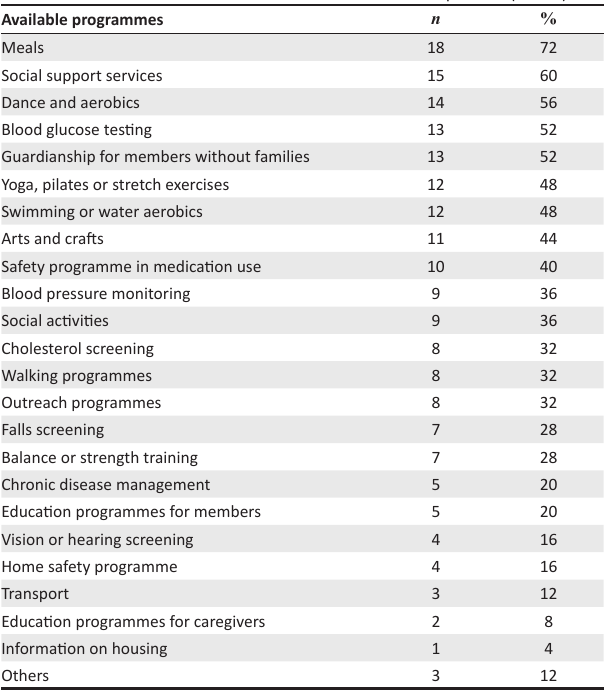
TABLE 4 : Self-reported signs and symptoms of members of service centres ( n =